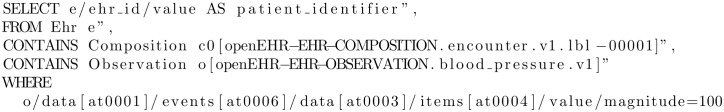
AQL query for the data structure in Fig 9.